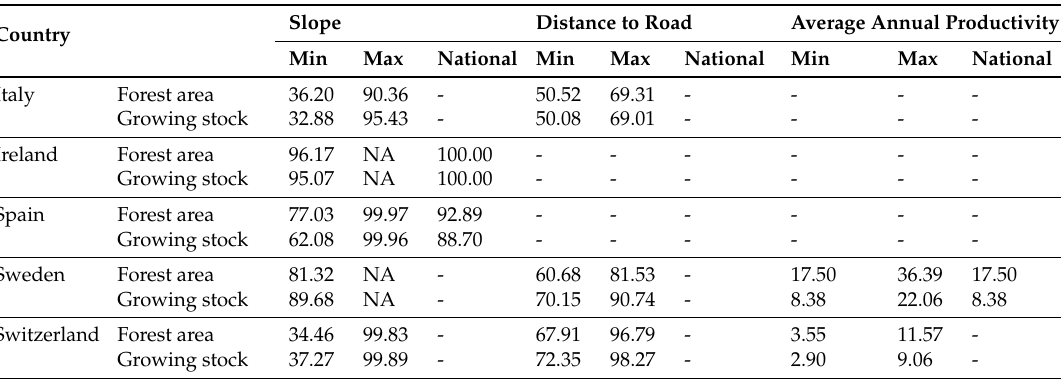
Table 3. Forest available for wood